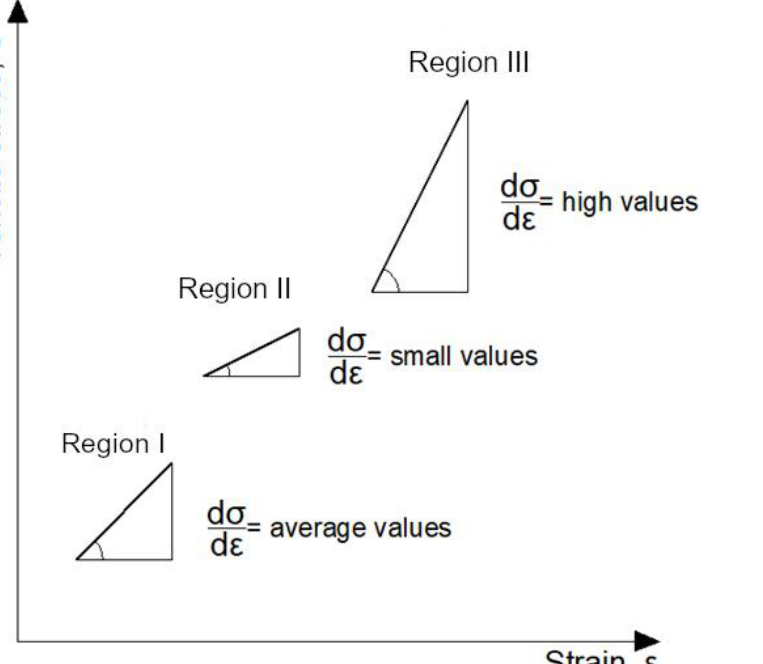
Figure 1. Stress–strain relationship during tensioning of materials featuring very high viscoelastic strain (elastomers). Adapted from ref. [30,31].